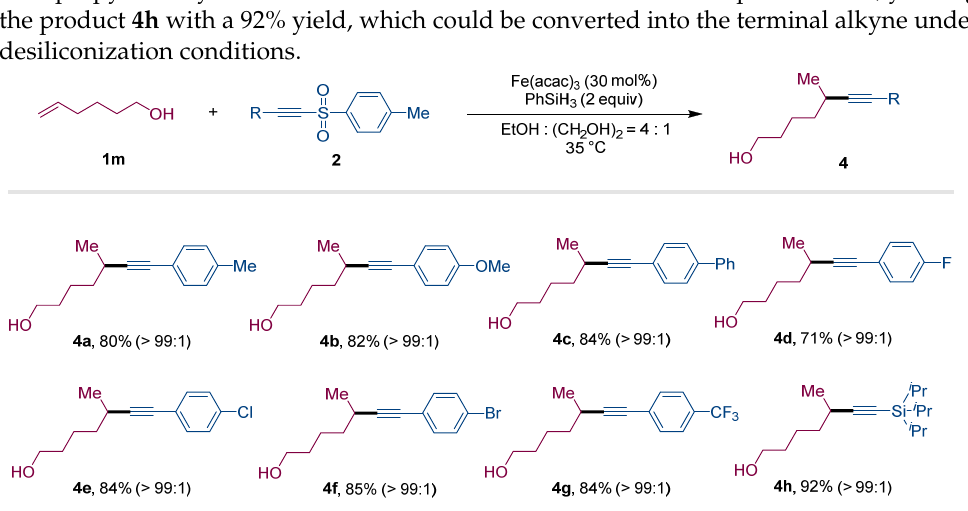
5 of 13 Figure 1. Substrate scope of alkenes a . a Standard conditions: 1 (0.3 mmol, 1.5 equiv), 2a or 2b (0.2 mmol, 1.0 equiv), Fe(acac) 3 (30 mol%), PhSiH 3 (0.4 mmol, 2.0 equiv), in EtOH (0.8 mL) and (CH 2 OH) 2 (0.2 mL) at 35 °C for 12 h, isolated yields.